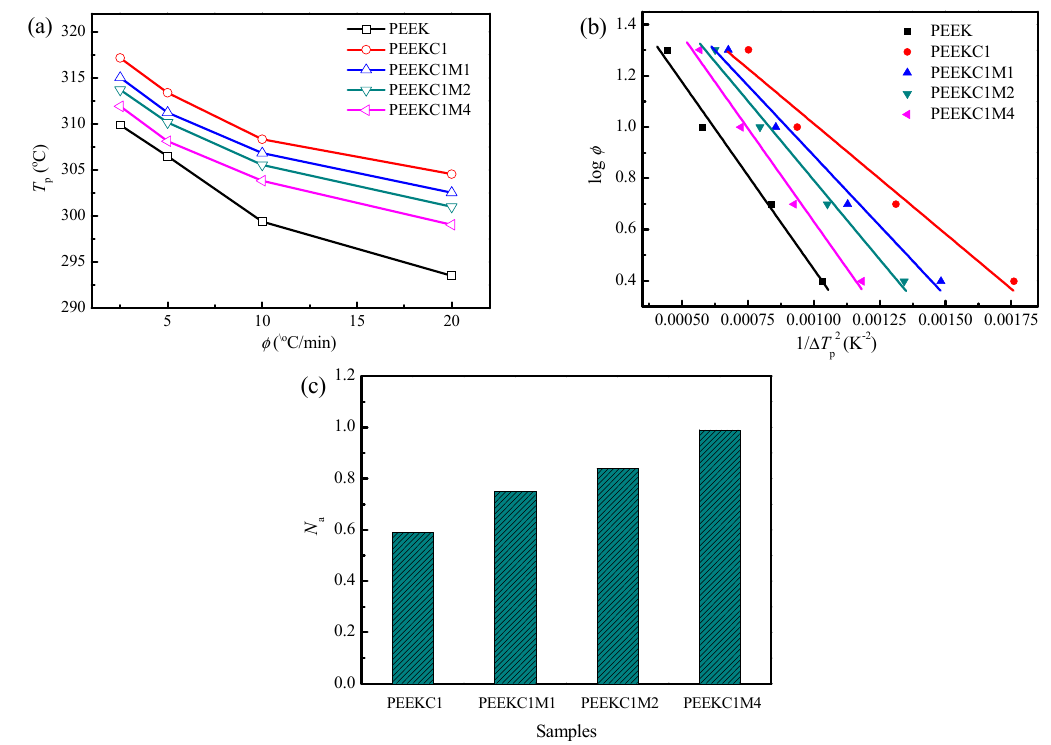
Figure 10. Correlation calculation of crystallization behavior: ( a ) T p diagram as a function of cooling rate, ( b ) Dobreva plots of log φ versus 1/ ∆ T p2 , and ( c ) variation of nucleation activity for PEEK nanocomposites.